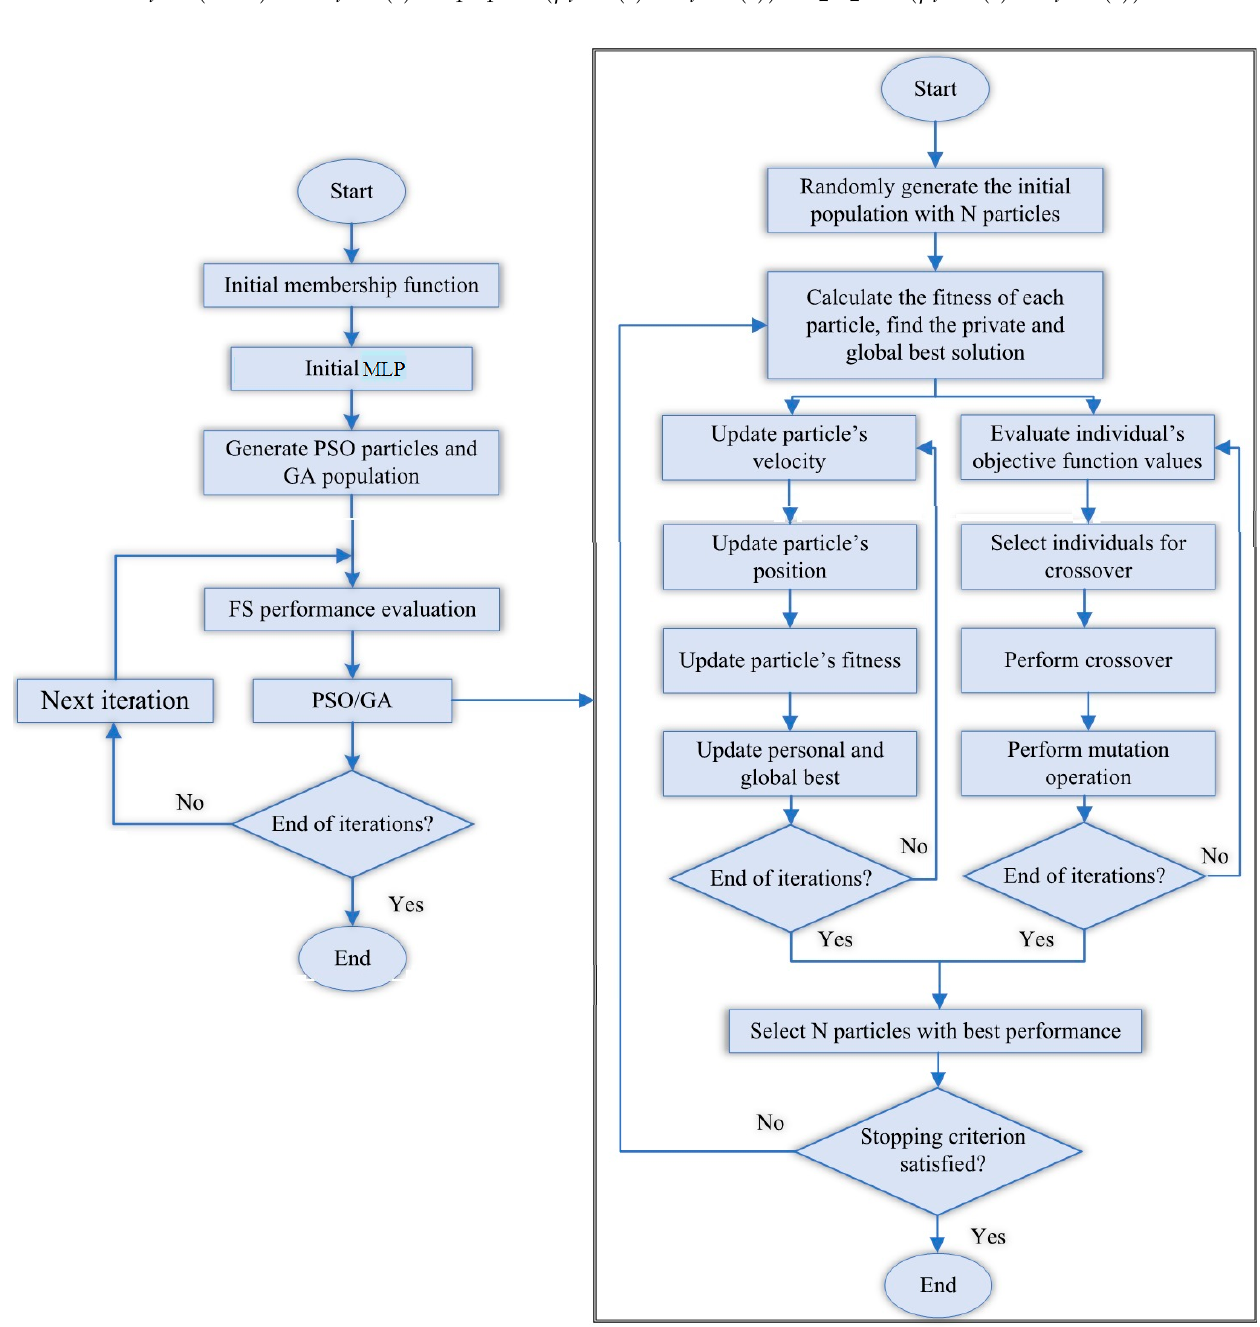
Figure 23. The flowchart of the sequential combination of hybrid MLP-PSO-FS algorithm.